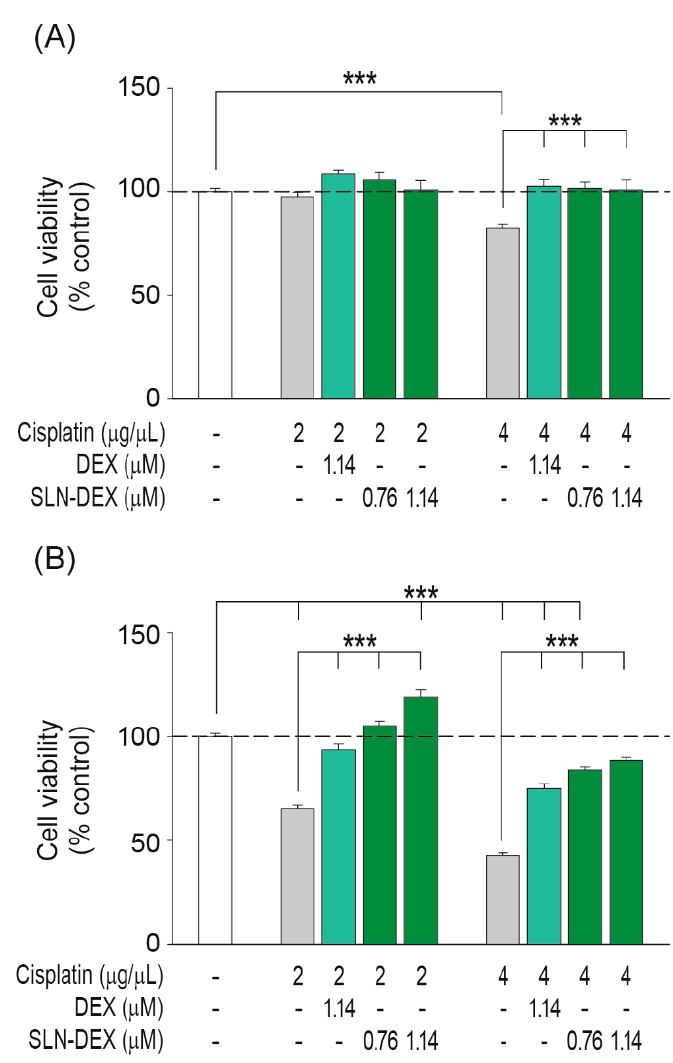
Figure 5. Comparative effects of SLN–DEX and dexamethasone on HEI-OC1 cells’ viability. Cell viability was evaluated by Cell Proliferation Kit II (XTT) assay. HEI-OC1 cells were treated for 24 h ( A ) or 48 h ( B ) with different concentrations of dexamethasone (DEX) either alone or combined with SLNs (SLN–DEX) in the absence or presence of 2 or 4 µg/mL cisplatin. Results are shown as mean ± SEM from four independent experiments. The significance of the differences was evaluated using one-way ANOVA testing; *** p < 0.001.